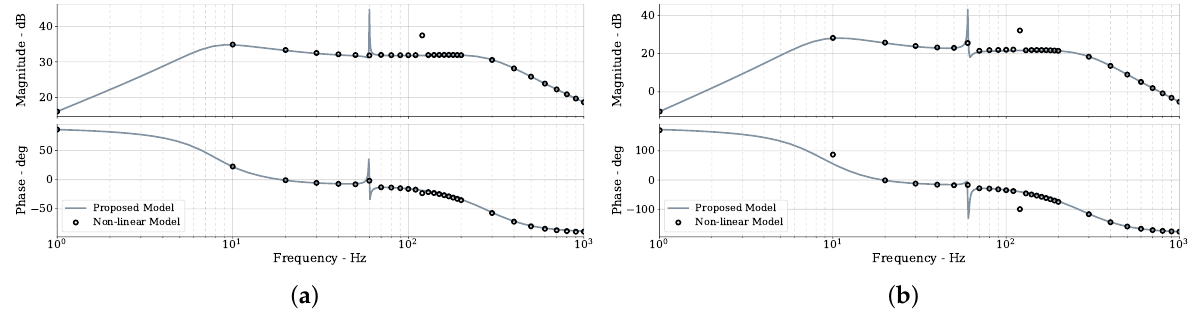
Figure 5. Frequency responses obtained for the proposed (linearized) and non-linear models for Z th . ( a ) Self-related term; ( b ) Cross-coupling